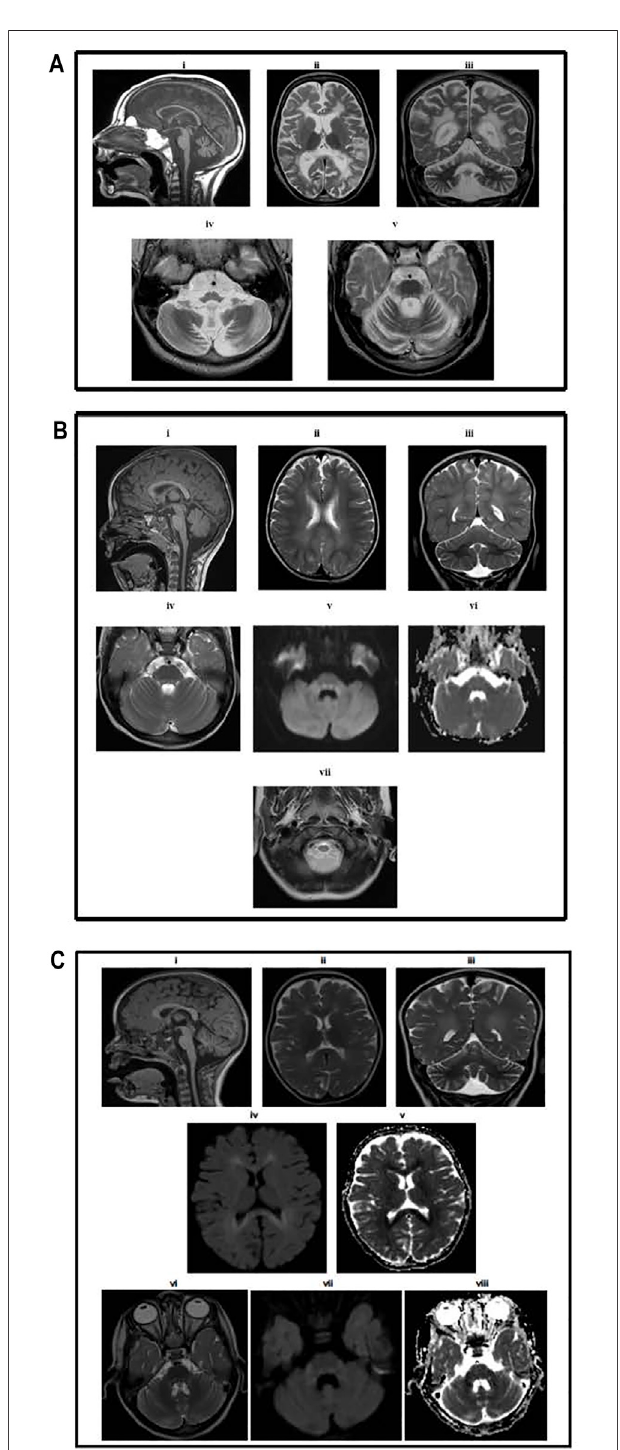
FIGURE 2 | (A) Brain MRI results for Patient II-1. MR examination of the brain at the age of 5. (i) T1-weighted image showing atrophy of the corpus callosum and cerebellum and medulla oblongata and upper cervical spinal cord with normal-sized pons and midbrain. Axial (ii) and coronal (iii) T2- weighted images demonstrating extensive high signal intensity in the